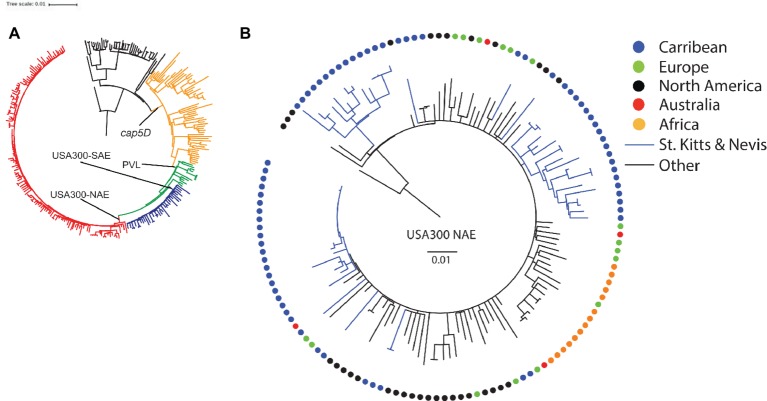
Rooted phylogenies of (A)
S. aureus ST8 isolates from St. Kitts and Nevis and from a global, representative collection (n = 224) described by Strauß et al. (2017), and (B) a detailed presentation of the 135 isolates belonging to the USA300-NAE lineage. Colored circles depict geographic region of origin. The scale bar indicates the substitution rate.